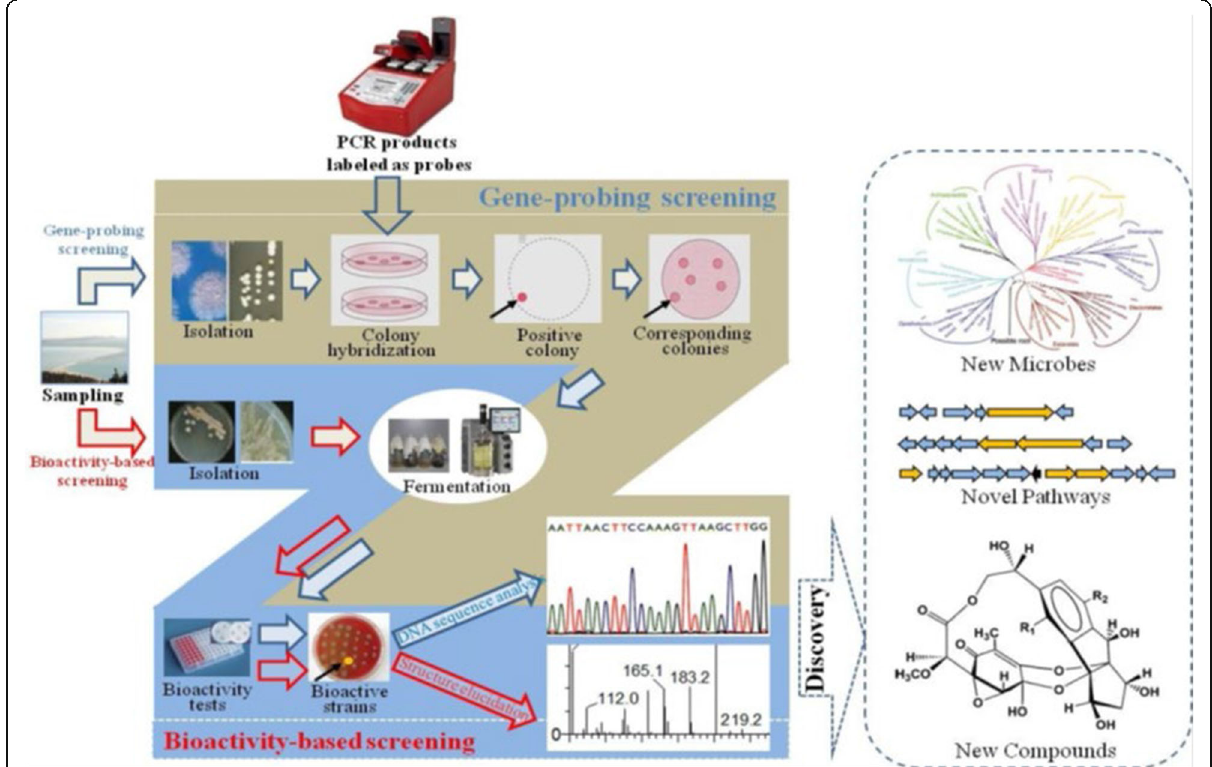
Fig. 2 The combined strategy of gene-based screening and bioactivity-based screening for marine microbial natural products ’ (MMNPs)